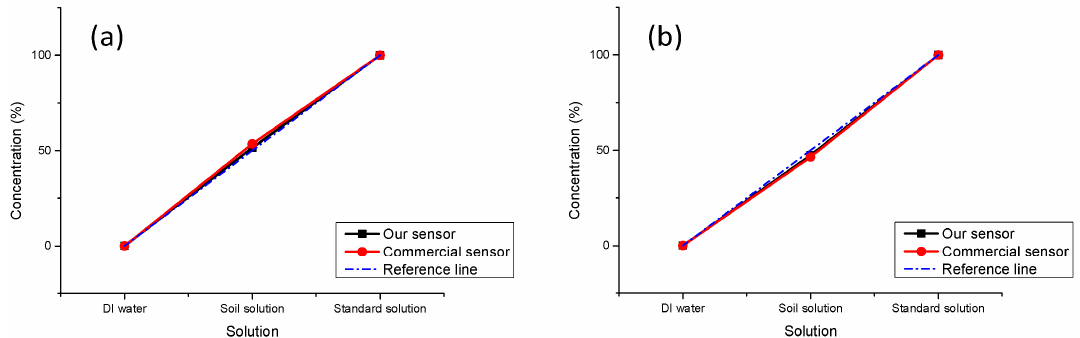
Figure 8. Anti-interference test results for our sensor (black line) versus the commercial equipment (red line). The blue line is the reference line. Both devices are tested in a dark environment ( a ) and in a normal light (about 300 lx) environment ( b ).